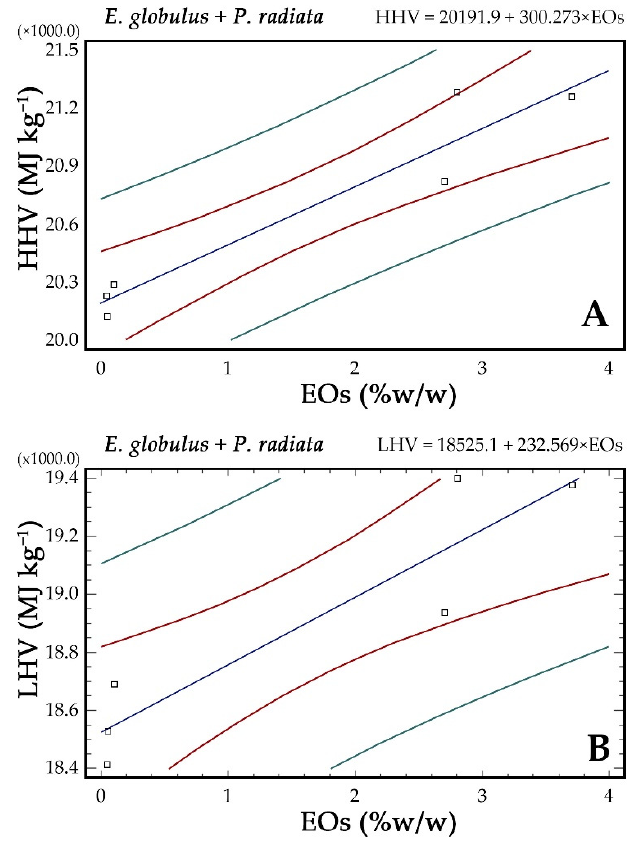
Figure 8. Statistically significant correlation between essential oil concentrations of Eucalyptus globulus and Pinus radiata samples, with respect to ( A ) higher heating value and ( B ) lower heating value. Empty black squares represents data points, while blue strait line represents the least squares regression fit. Red lines (inner limits) represent the confidence interval, while green lines (external limits) represent the prediction limits, both at 95% confidence level.